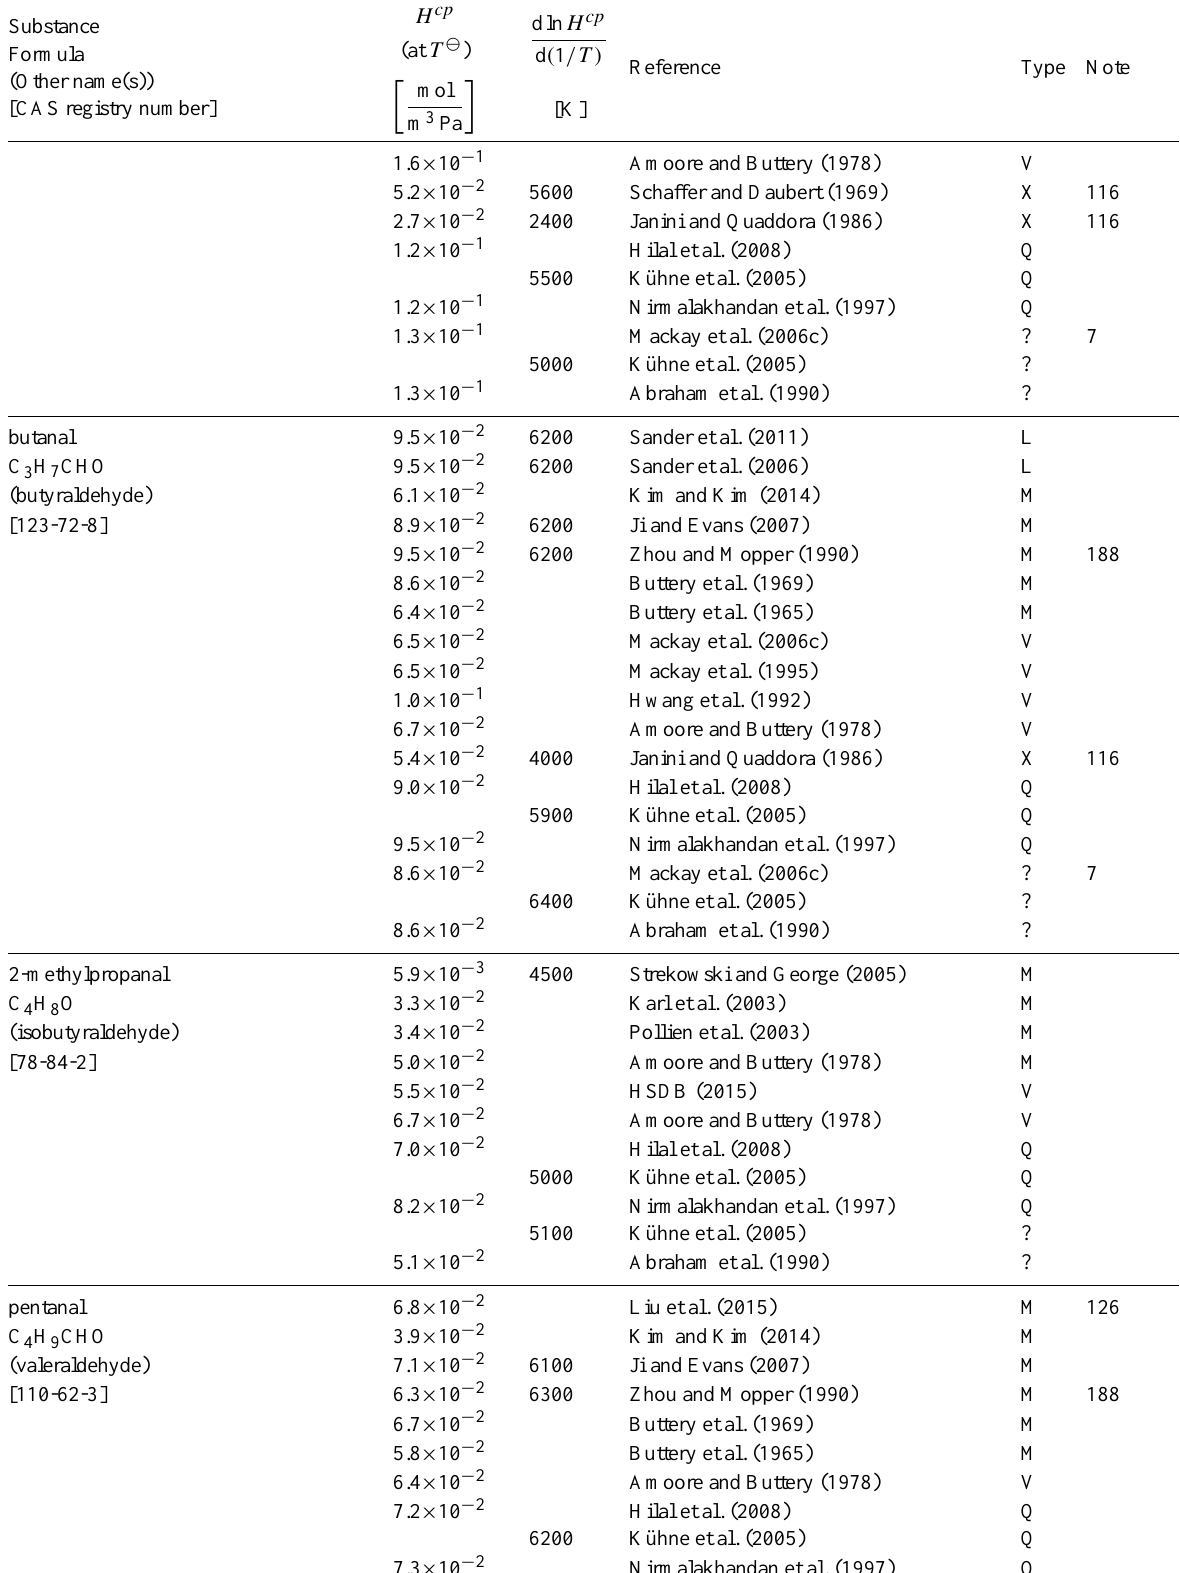
Table 6: Henry’s law constants for water as solvent